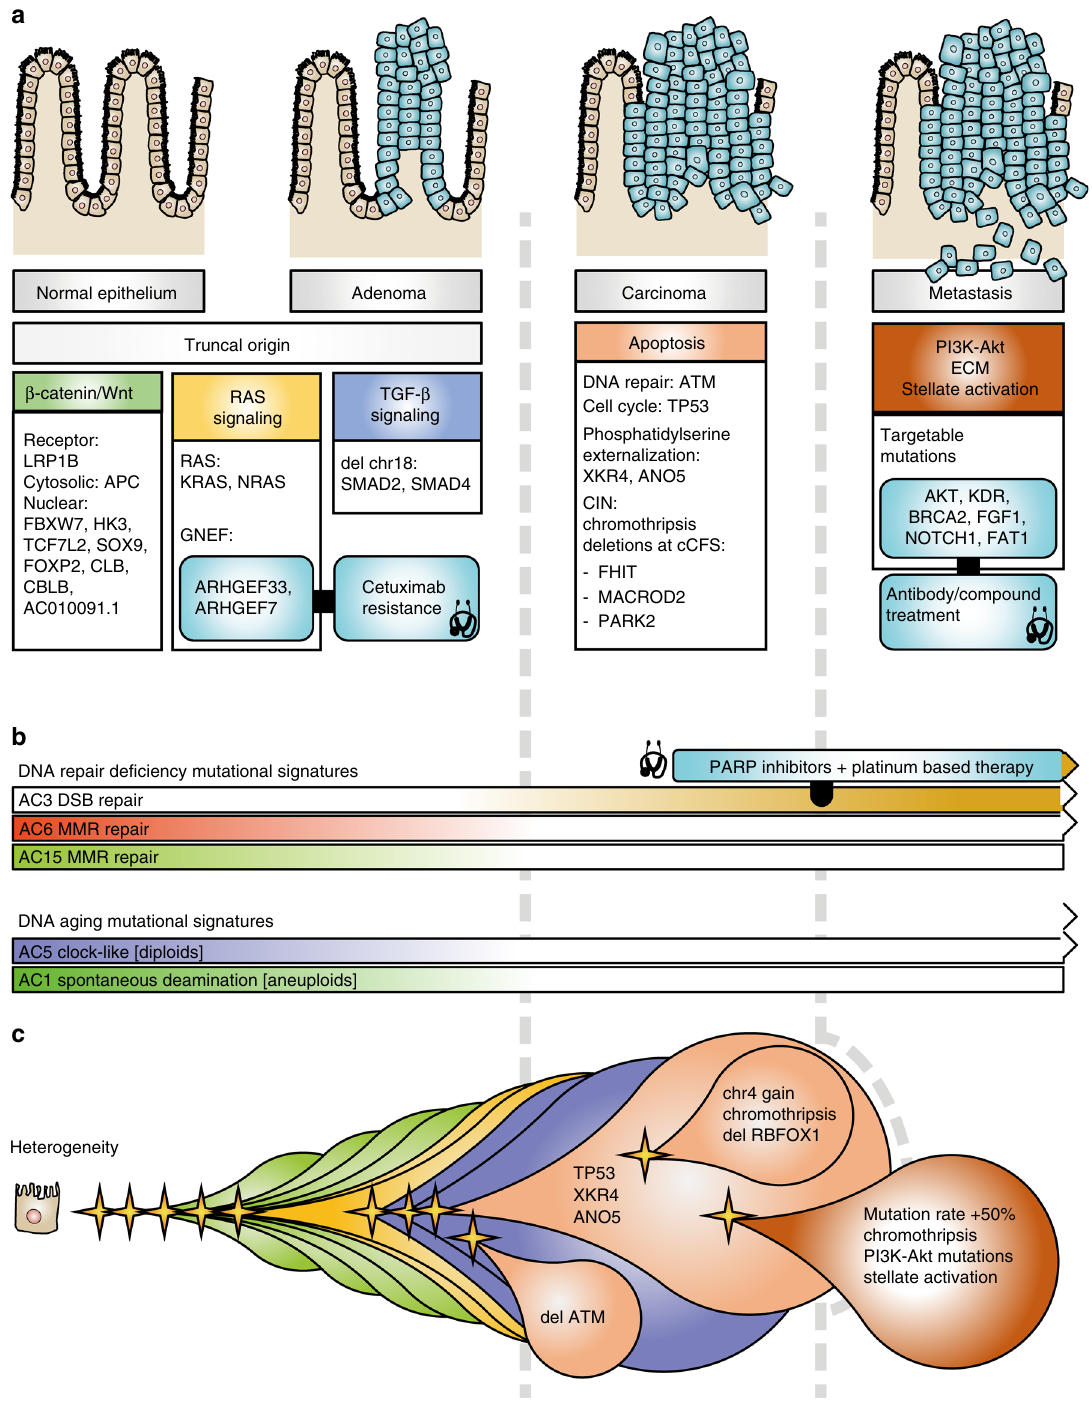
Fig. 7 Model of colorectal cancer and metastasis progression and therapeutic implications. A summary cartoon of how recurrent somatic mutations identi fi ed within this study fi t into established colorectal progression models a . The top cartoons represent the transition from normal epithelial cells to metastasis (left to right). Beneath the cartoons are tables of genes and genetic lesions that were mutated in our cohort, sorted in tables related to possible pathway function. Change of relative exposure to mutational signatures are shown as horizontal bars where the strength of exposure corresponds to the strength of color in the bar, relative to tumor evolution (left to right) b . Cartoon representation of lesion (stars) accumulation giving rise to tumor heterogeneity c . Balloons are colored according to pathways, as the table headers in a , showing mutations in Wnt (green), RAS (orange), TGF- β (blue) signaling, and mutations acquired in carcinogenesis (brown), and metastasis (dark brown) formation. We show events which might not give rise to further progression. Mutations with implications on therapy decision are shown in light blue boxes with rounded corners, and linked to boxes with therapy consideration via a thick black line a , b . Gray vertical dashed lines separate out lesions corresponding to truncal origin, tumor, and metastasis